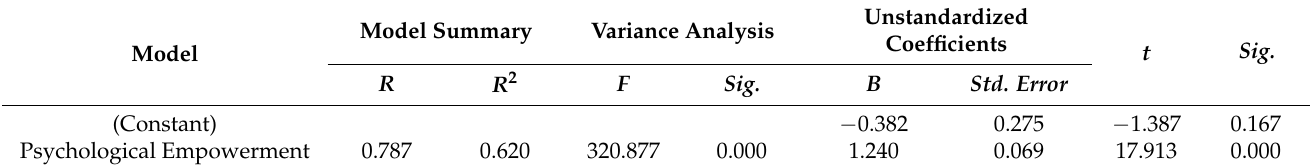
Table 21. Regression Analysis of Psychological Empowerment on Employee Work